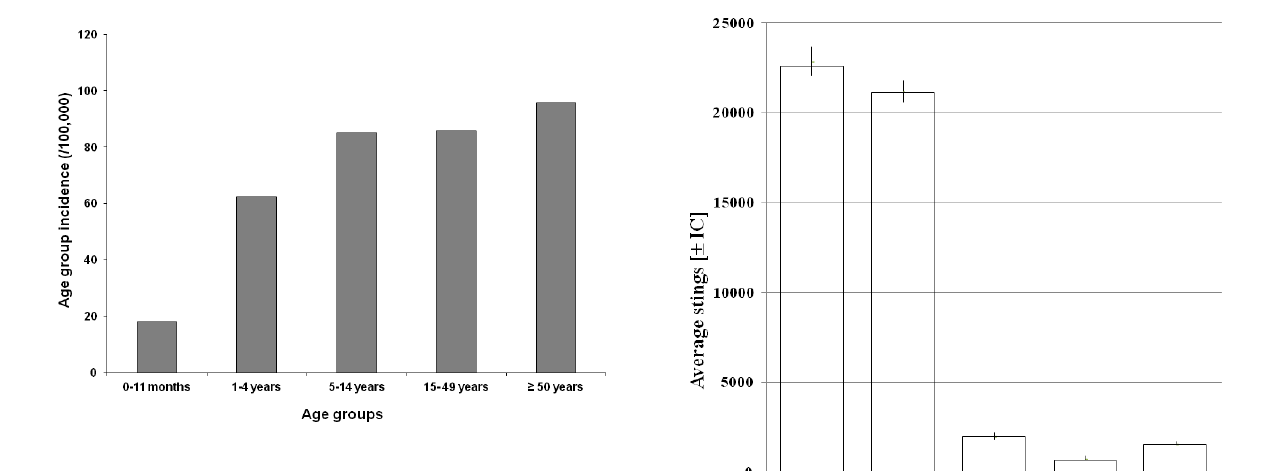
Figure 3. Incidence of scorpion stings according to age.